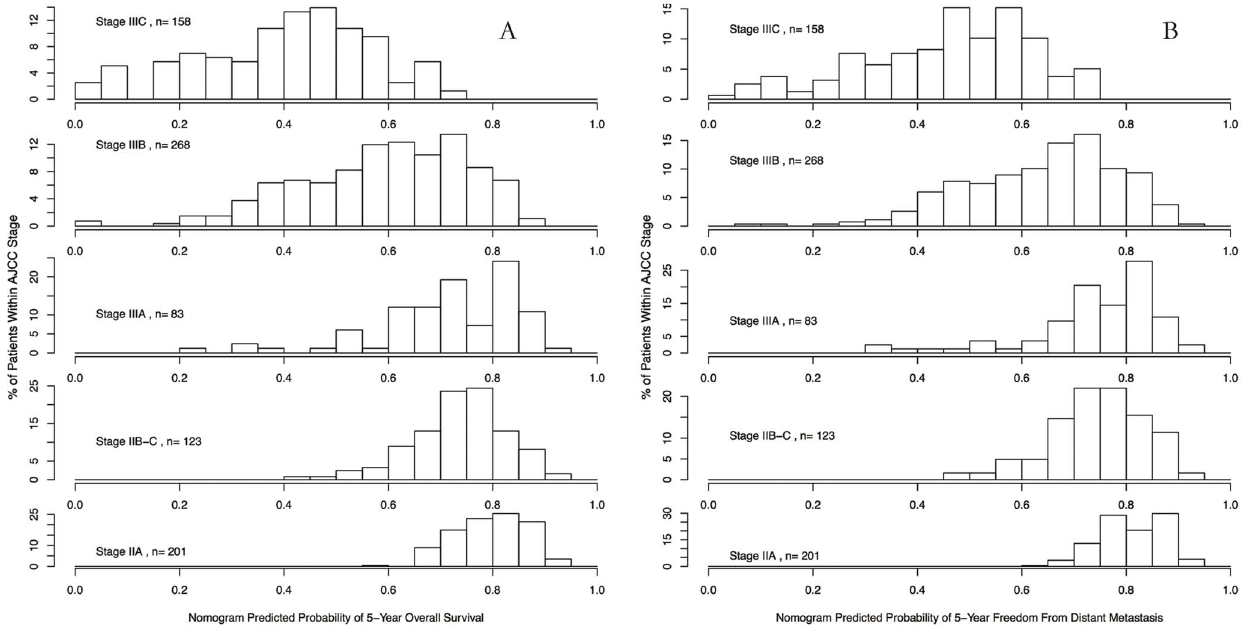
Figure 3. Histogram of nomogram-predicted 5-year overall survival rate (A) and distant control rate (B) within each subgroup of the 7 th edition of American Joint Committee on Cancer (AJCC) stage.